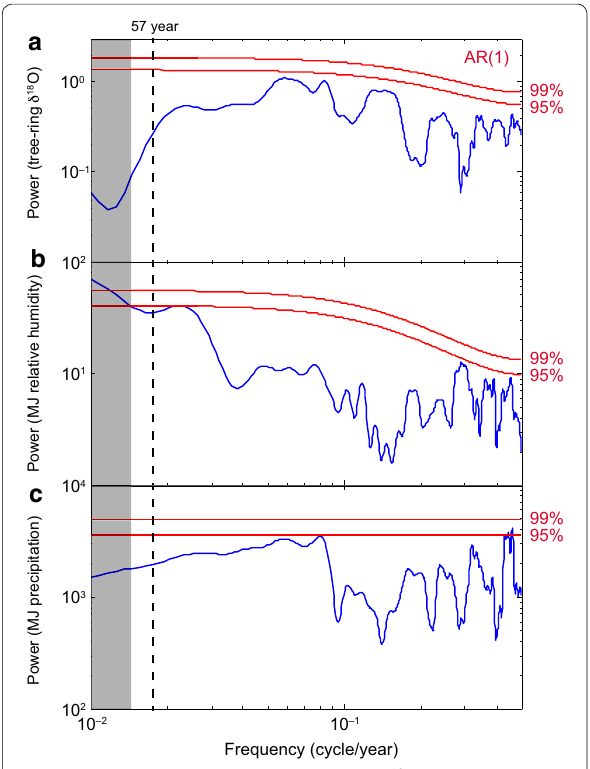
Fig. 4 Results of MTM analysis for a tree-ring δ 18 O, b MJ relative humidity, and c MJ precipitation in Sendai station. Analysis period is from A.D. 1927 to 2010. Red solid lines indicate 95 and 99% significant level, and black dot line corresponds to 57-year cycle